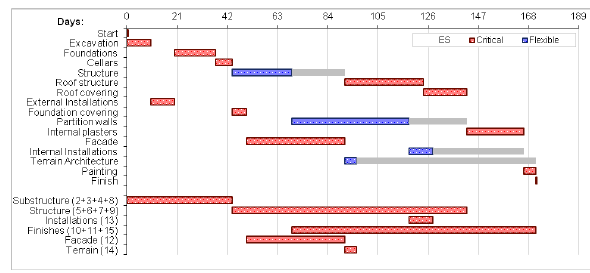
Figure 9: The project schedule for the minimization of CF max with the Priority rule 4: priority for works with earlier starting time.